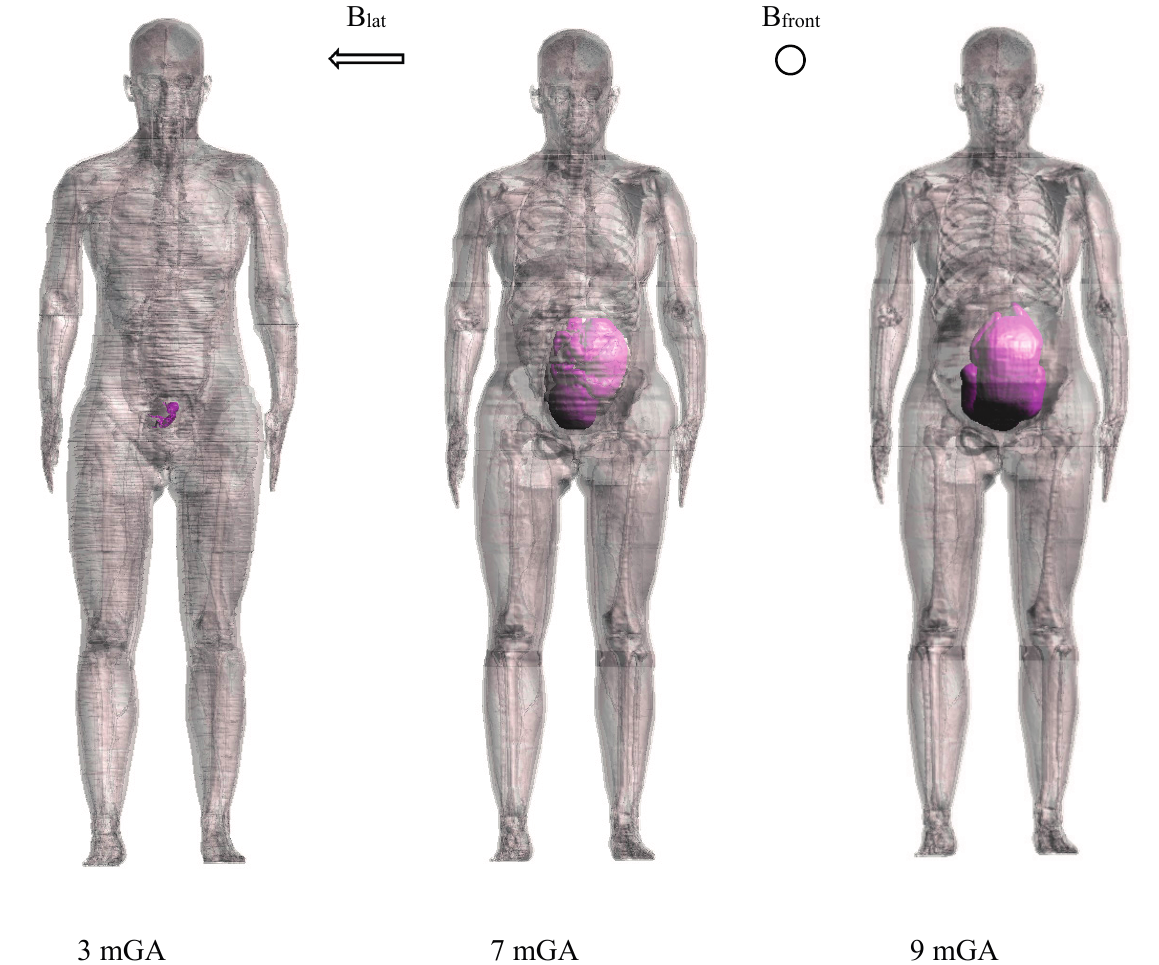
Figure 1. Exposure scenarios representation of the three pregnant woman models at 3, 7 and 9 months GA according to